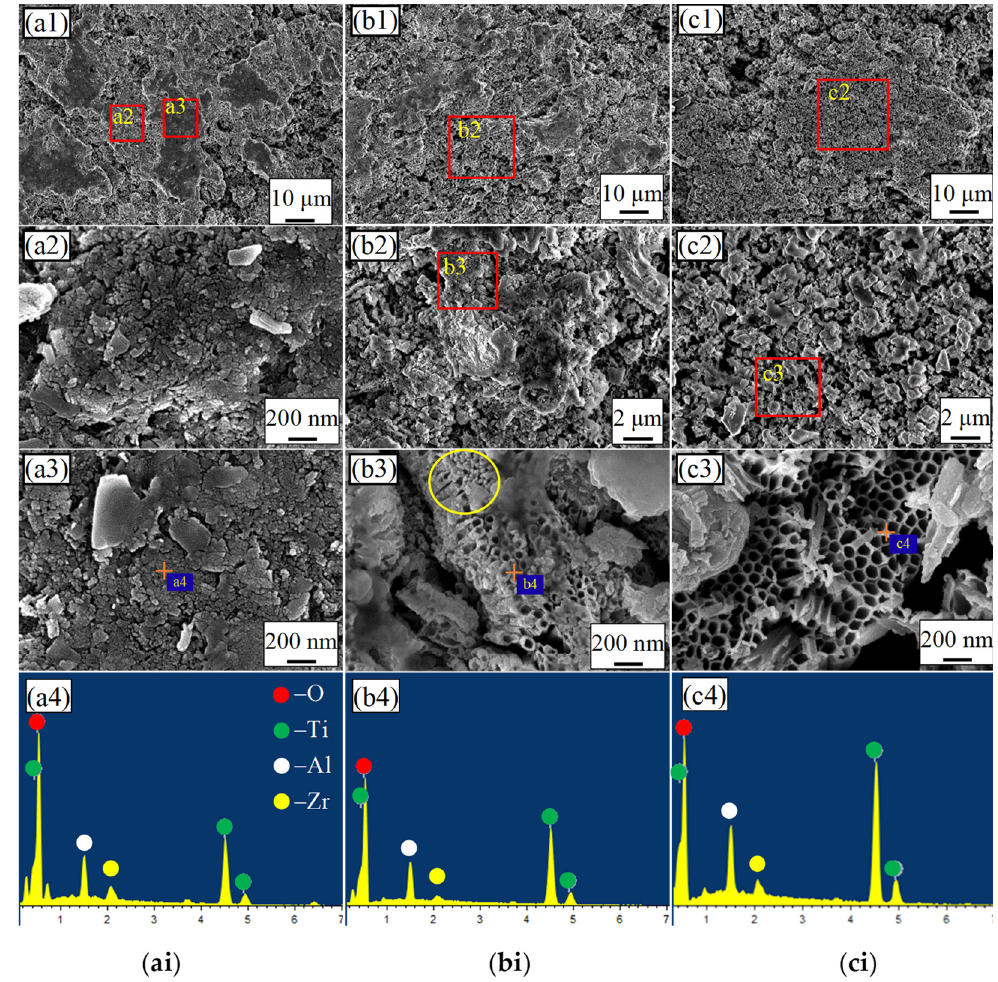
Figure 2. SEM and EDS images of the AOF on specimens ( ai ) A20V, ( bi ) A40V, and ( ci ) A60V; ( a1 , b1 , c1 ) the corresponding SEM images; ( a2 , a3 , b2 , b3 , c2 , c3 ) are the corresponding enlarged SEM images; ( a4 , b4 , c4 ) are the corresponding EDS images .